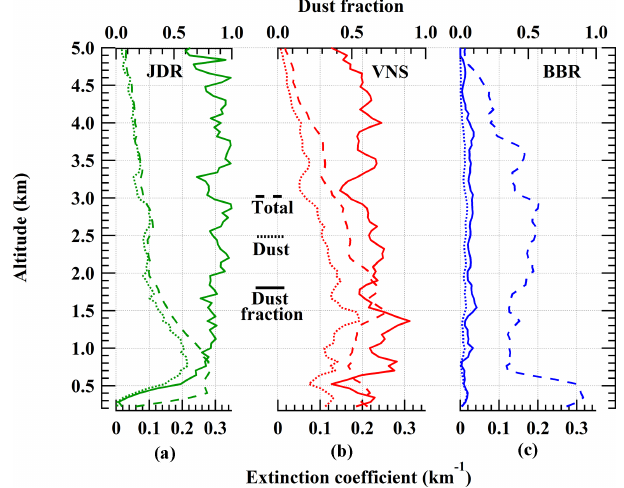
Figure 7. CALIPSO-derived total (dashed line) and dust (dotted line) extinction profiles over the stations (a) JDR, (b) VNS and (c) BBR. Also shown is the dust fraction (solid line) for the three sta-